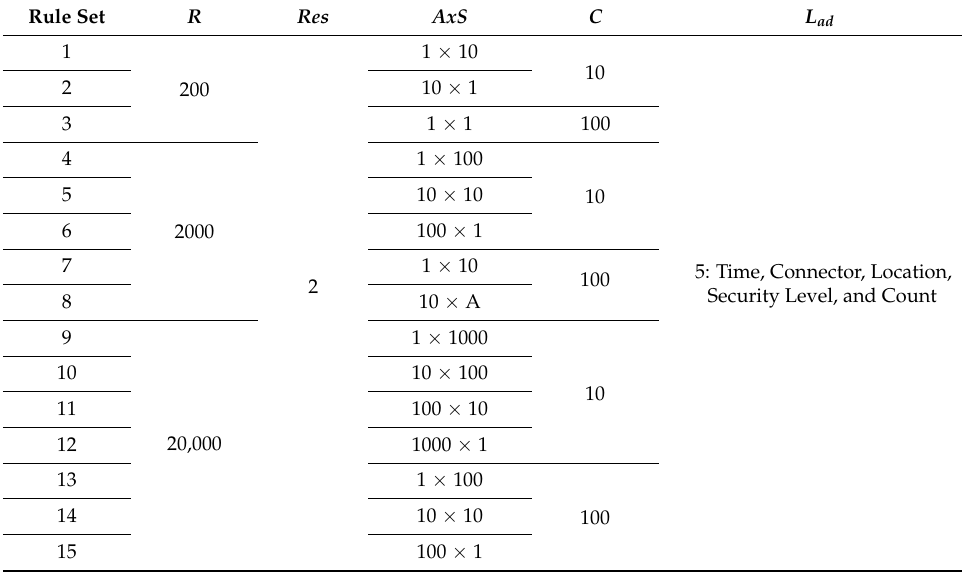
Table 1. Experimental Assessment Rule